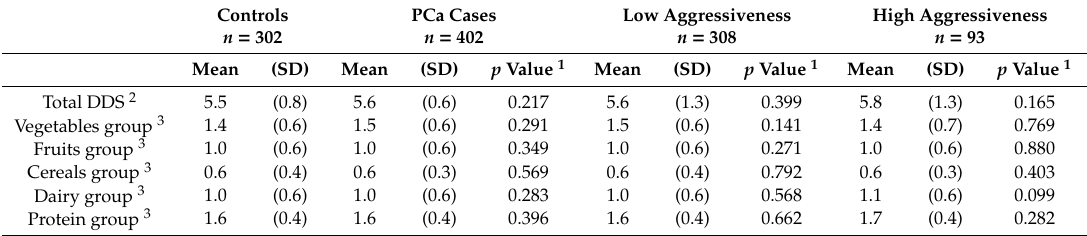
Table 3. Assessment of the DDS and variety in each food group according to the tumor aggressiveness.